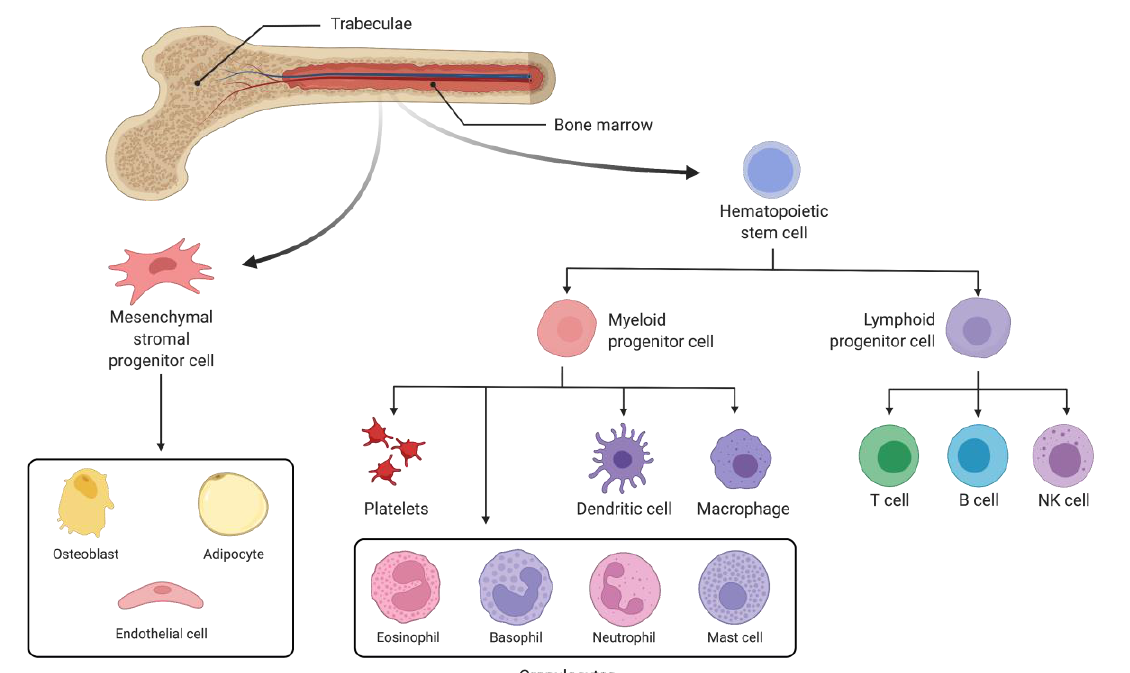
Figure 2. Hematopoietic stem cells and mesenchymal stem cells form the two primary cell types of the bone marrow stem cell niche. Mesenchymal cells can differentiate into a variety of cell types while hematopoietic stem cells give rise to every component of the blood including immune cells via differentiation into myeloid or lymphoid progenitors. Myeloid progenitor cells differentiate into platelets, granulocytes, or monocytes, which themselves further differentiate into dendritic cells or macrophages. Lymphoid progenitors differentiate into T cells, B cells, and NK cells. The innate immune system is comprised of NK cells, granulocytes, monocytes, macrophages, and dendritic cells, which serve as messengers between the innate and adaptive immune